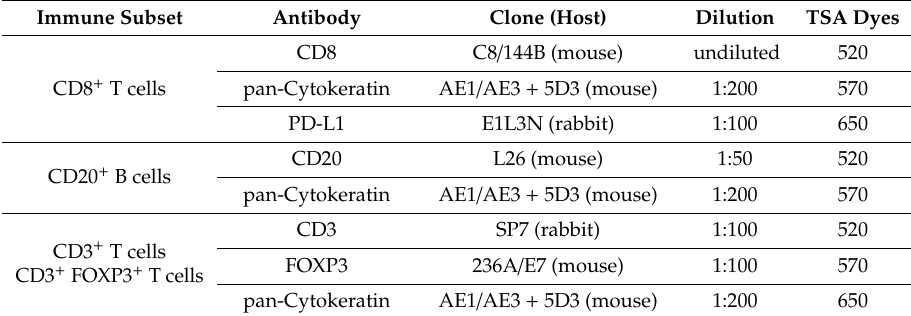
Table 1. The list of antibodies used for fluorescent multiplex immunohistochemistry